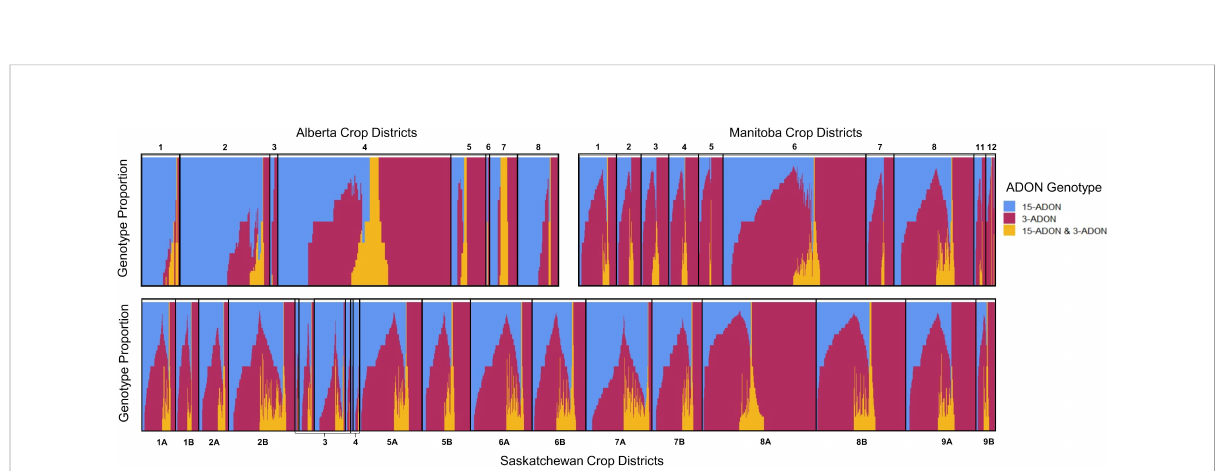
FIGURE 5 Proportion of ADON genotypes in each sample by western Canadian crop district. Each vertical bar represents a single sample where multiple FDK were tested. Samples corresponding to crop districts in Alberta (top left), Manitoba (top right), and Saskatchewan (bottom) contained kernels that were positive for 15-ADON (blue), 3-ADON (red), or both genotypes